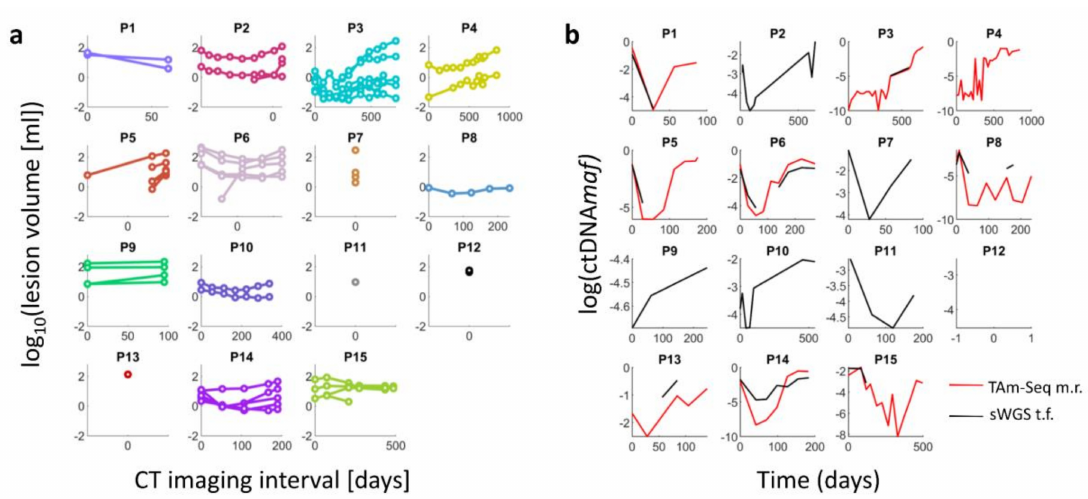
Figure 3. ( a ) Comparison of lesion volume for individual lesions in each subject measured on CT against date. Day 0 represents the date of first imaging. These graphs show considerable variation in tumor growth between patients and across time points. The largest lesion in each case showed volume variations which reflected standard RECIST 1.1 measurements. ( b ) ctDNAmaf by days elapsed from baseline measurement. Red line shows TAm-Seq mutation rate; black line shows shallow whole genome tumor